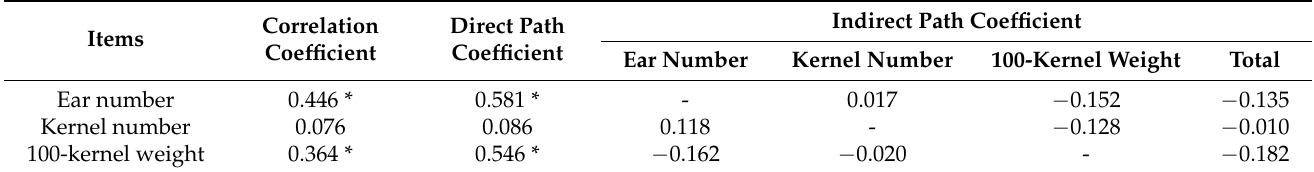
Table 2. Correlation coefficient and path coefficient among grain yield and yield components ( n = 60).